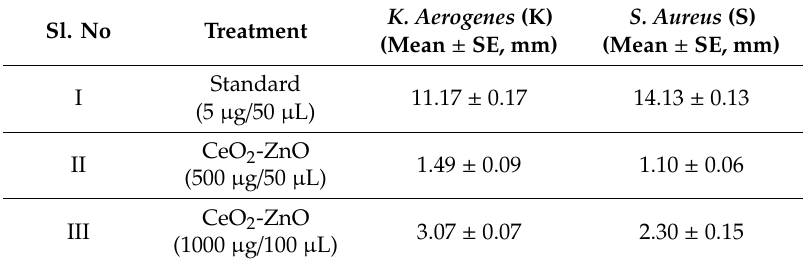
Figure 12. Zone of inhibition of pathogenic bacterial strains K. aerogenes (K) and S. aureus (S) for the CeO 2 -ZnO nanocomposite. Table 1. Zone of inhibition of the CeO 2 -ZnO nanocomposite tested bacterial strains